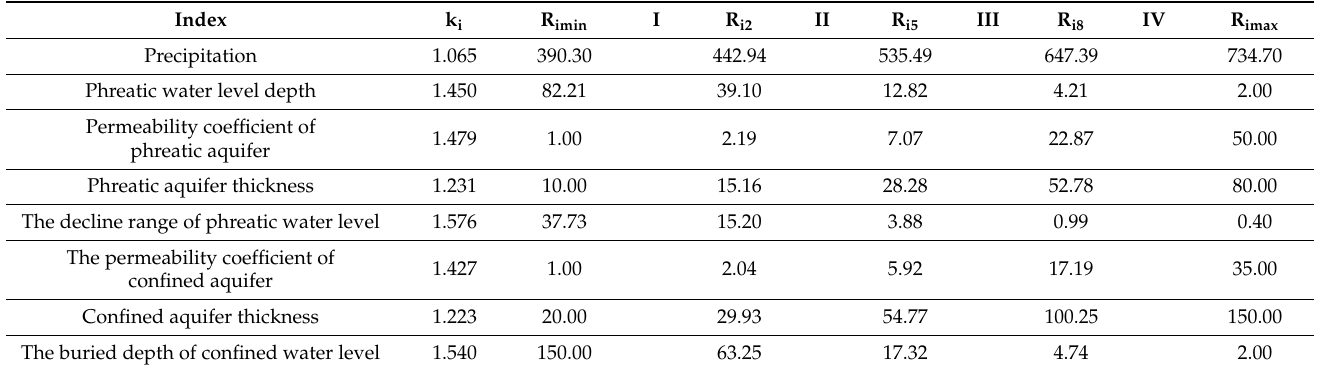
Table 1. Standard limits of the groundwater carrying capacity evaluation